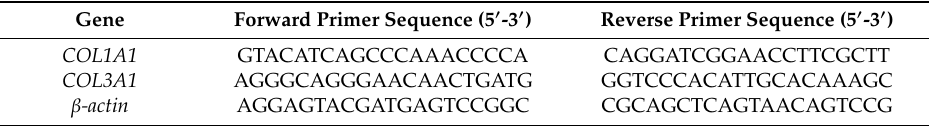
Table 1. Primers used for